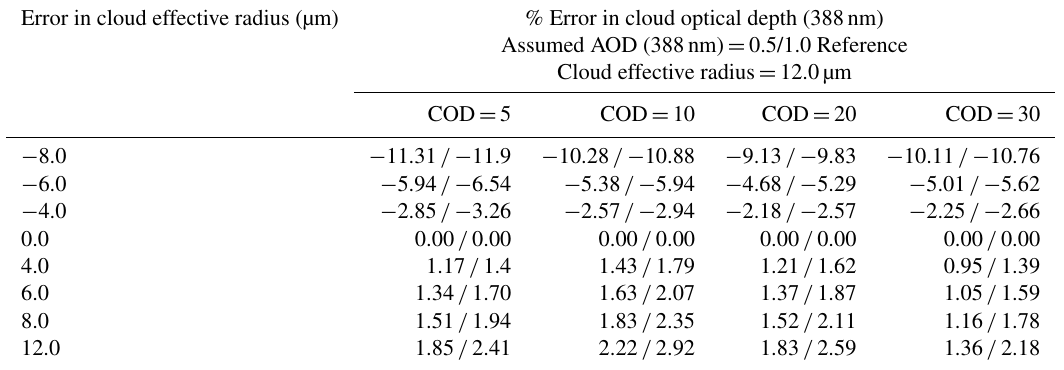
Table 7. Theoretical error (%) in aerosol-corrected COD (388nm) due to the uncertainty in the assumption of cloud effective radius. Error in cloud effective radius (µm) % Error in cloud optical depth (388nm) Assumed AOD (388nm) = 0.5/1.0 Reference Cloud effective radius = 12.0µm COD =